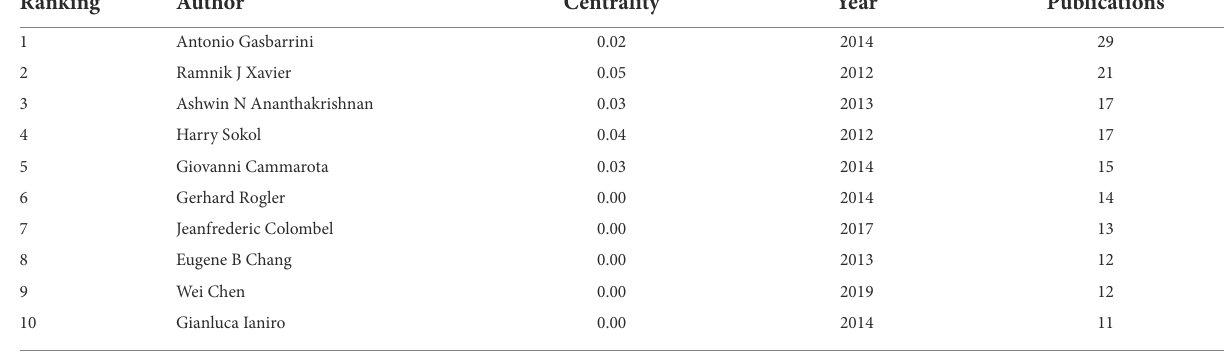
TABLE 3 The ten authors with the highest number of articles.